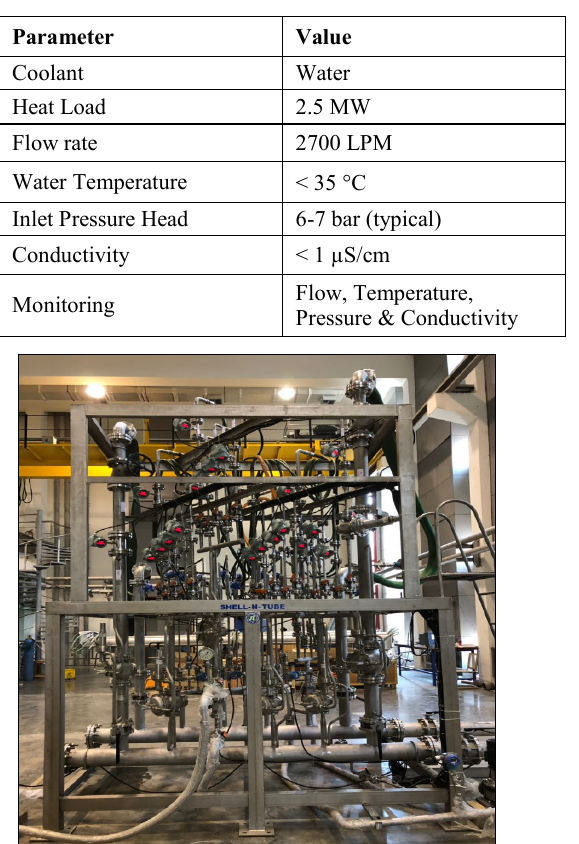
Table 2 : Main Parameters of Cooling distribution system